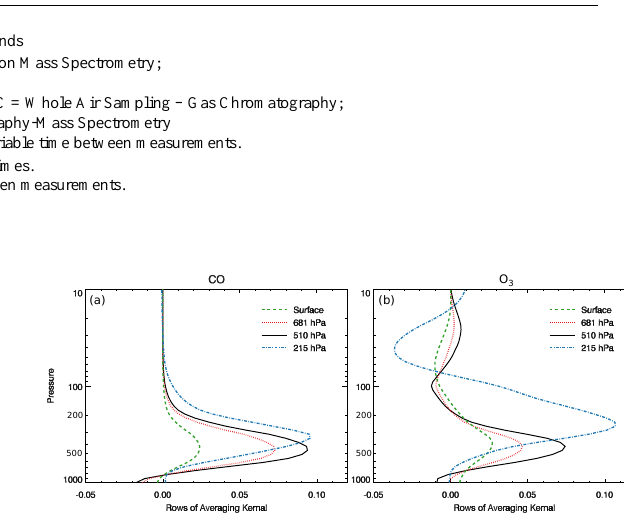
Table 3. DC-8 measurements used in this analysis Species a Method b Principal Investigator Ref. Avg. Time for Regression with CO CO TDLAS G. Diskin Sachse et al. (1987), NA Diskin et al. (2002) O 3 , NO, NO 2 , NO y Chemiluminescence A. Weinheimer Weinheimer et al. (1994) 1s CO 2 Non-dispersive IR S. Vay Vay et al. (2003) CIMS Total PNs, Total ANs TD-LIF Day et al. (2002) 60s c Fine Aerosol NO 3 ( p ) HR-ToF-AMS HCN, HNO 3 ( g ) CIMS NMHCs WAS-GC Blake et al. (2003) Variable d Organic gases, CH 3 CN PTR-MS NMHCs, OVOCs GC-MS E. Apel and Apel et al. (2003)